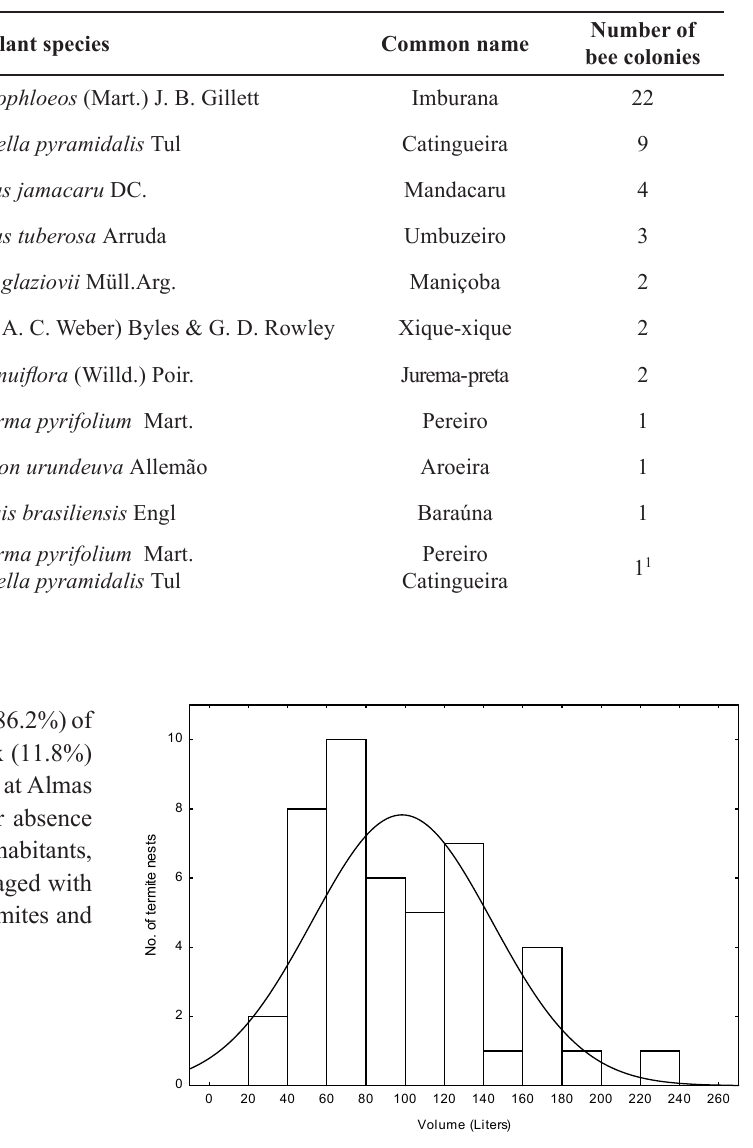
Table 1 . Plant species used by Constrictotermes cyphergaster to support their nests where colonies of Partamona seridoensis were found from March 2008 to December 2010.